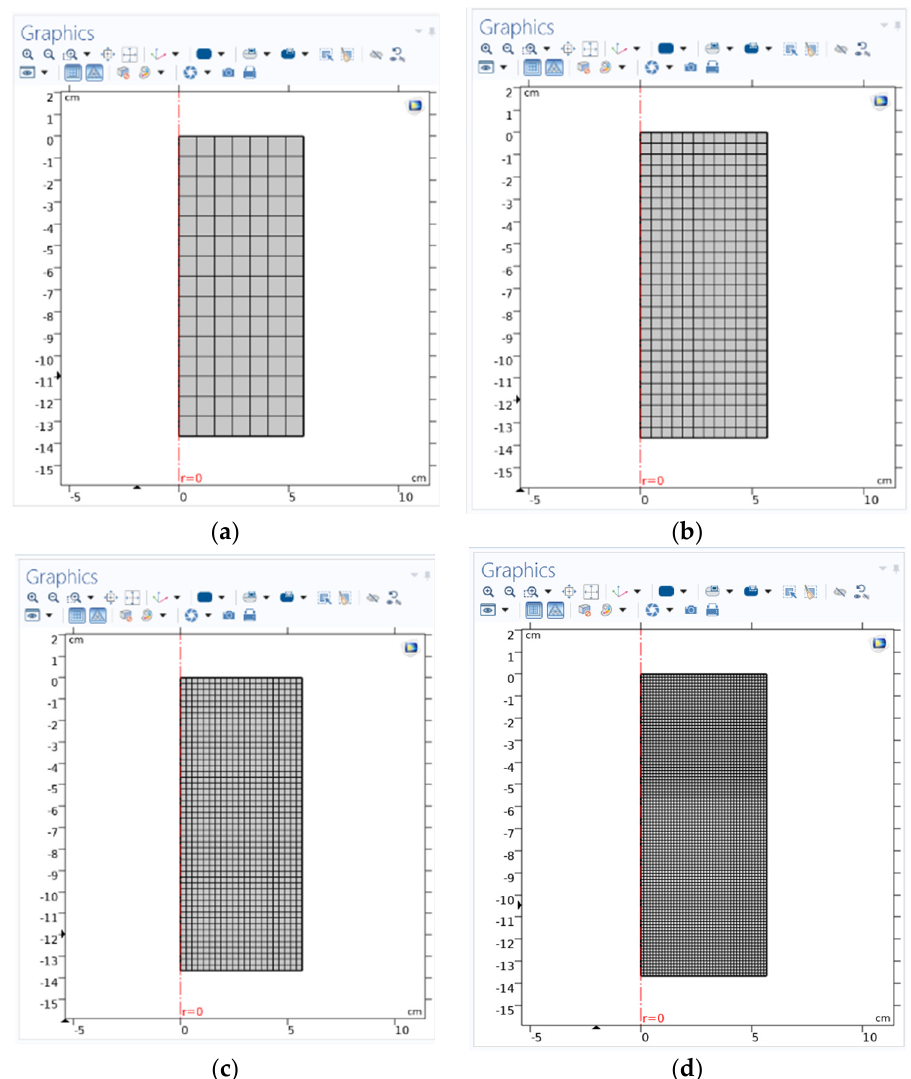
Figure 5. Grid. ( a ) Normal; ( b ) finer; ( c ) extra fine; ( d ) extremely fine.